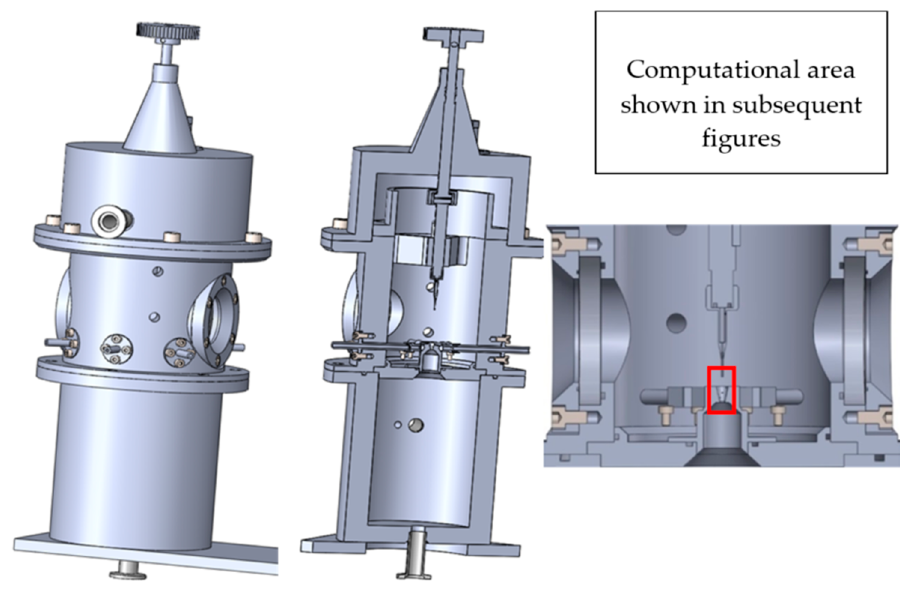
Figure 1. Experimental chamber.